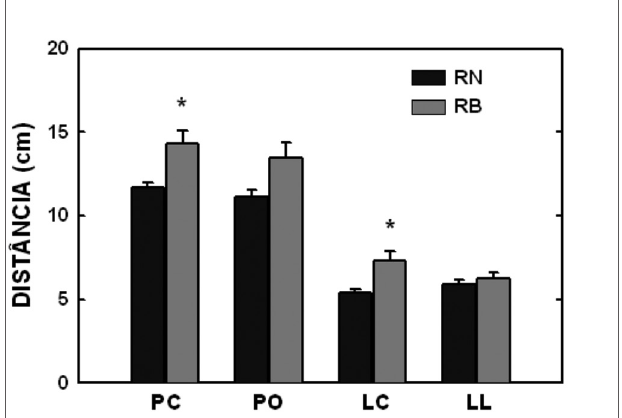
Figura 1. Mensuração das distâncias das variáveis posturais em rela- ção ao plano posterior. RN = grupo de crianças respiradoras nasais; RB = grupo de crianças respiradoras bucais; PC = projeção de cabeça; PO = projeção de ombro; LC = Lordose cervical; LL =Lordose lombar. * significativamente diferente com relação a RN (p<0,05). Com relação à espirometria, todas as variáveis